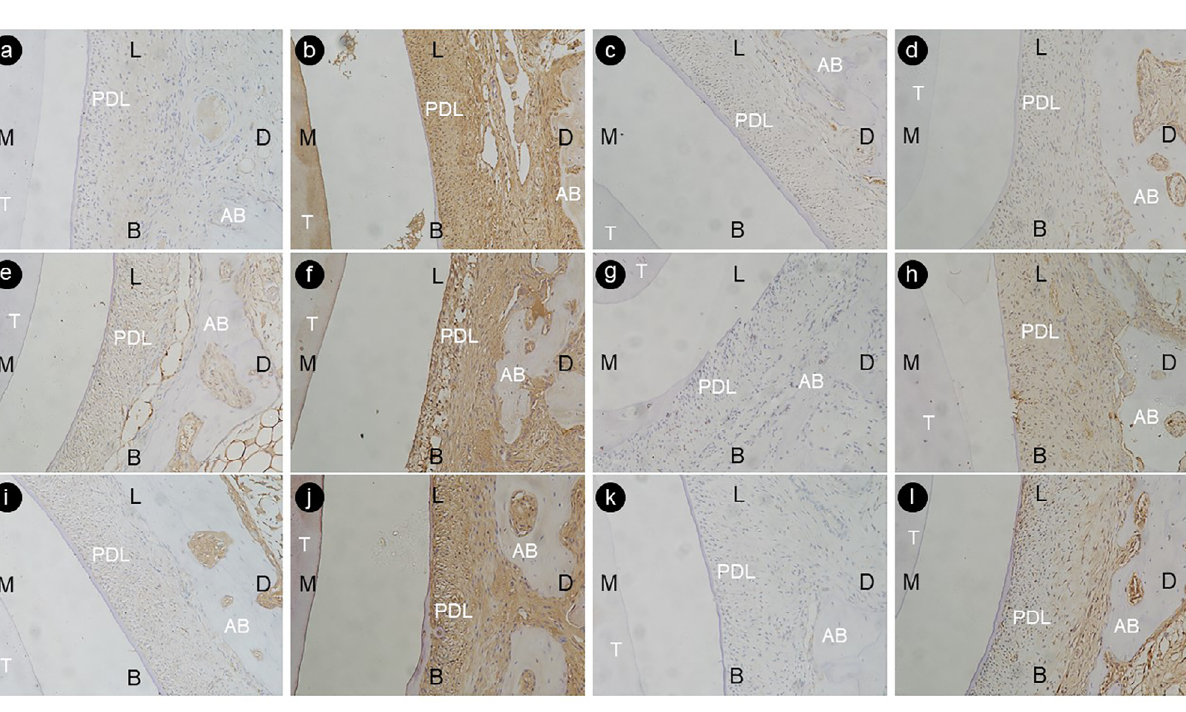
Figure 4- Immunohistochemical staining of PCNA, OCN, VEGF and TGF-β1 on the tension area of the moving premolar of the control side (×200). a, PCNA, Group A; b, OCN, Group A; c, OCN, Group A; d, VEGF, Group A. e, PCNA, Group B; f, OCN, Group B; g, OCN, Group B; h, VEGF, Group B. i, PCNA, Group C; j, OCN, Group C; k, OCN, Group C; l, VEGF, Group C.